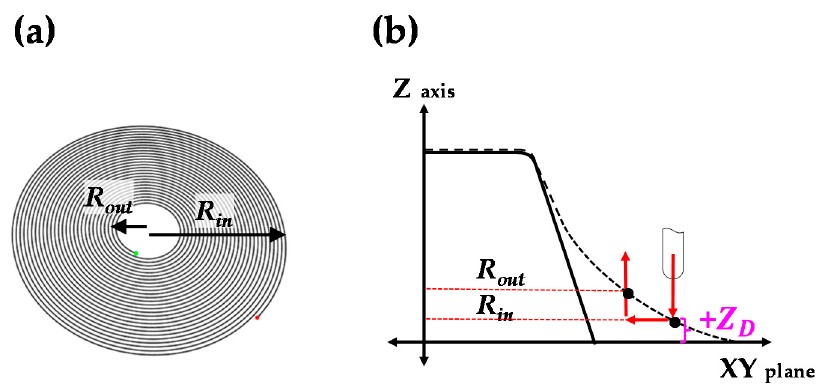
Figure 6. ( a ) Schematic figure of the tool path for the counter SPIF and ( b ) sectional view.